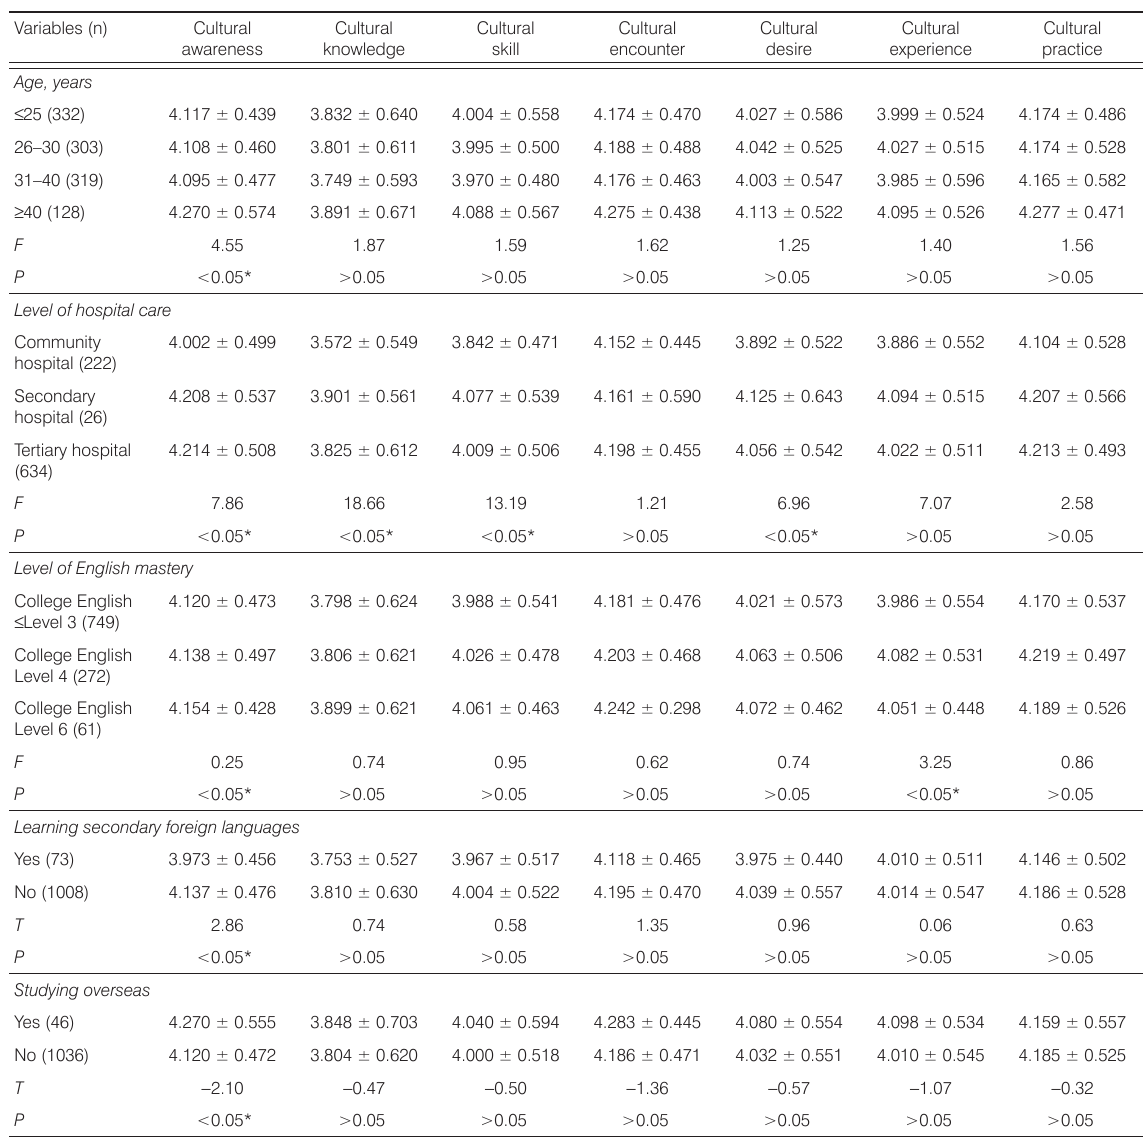
Table 2. Cultural competence scores by variables (M ±